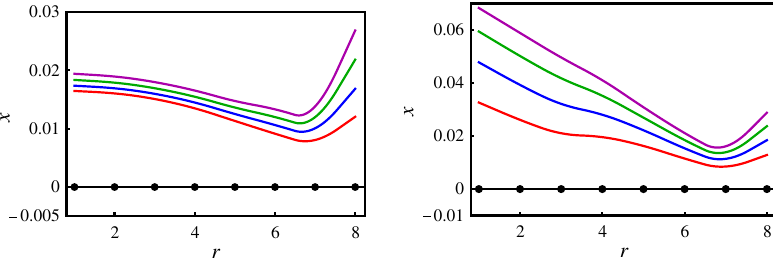
FIG. 5. Left: Spatial variation of the Néel (solid lines, with x ¼ N ) and ferromagnetic (black dots, with x ¼ M ) order parameters per unit cell, in the presence of uniform true magnetic field of strength 250 T. Right: The same quantities in a localized true magnetic field, of the strength 650 Tat the center of the system. The average magnetic field at each quasicircular ring of the honeycomb lattice decreases as B ð r Þ ¼ ð 690 − 40 r Þ T, towards the boundary of the system. Strength of the Hubbard interaction reads as U ¼ 0 . 4 (red line), 0.5 (blue line), 0.6 (dark green line), 0.7 (purple line). The ferromagnetic order is identically zero for all values of U , both in uniform and nonuniform true magnetic